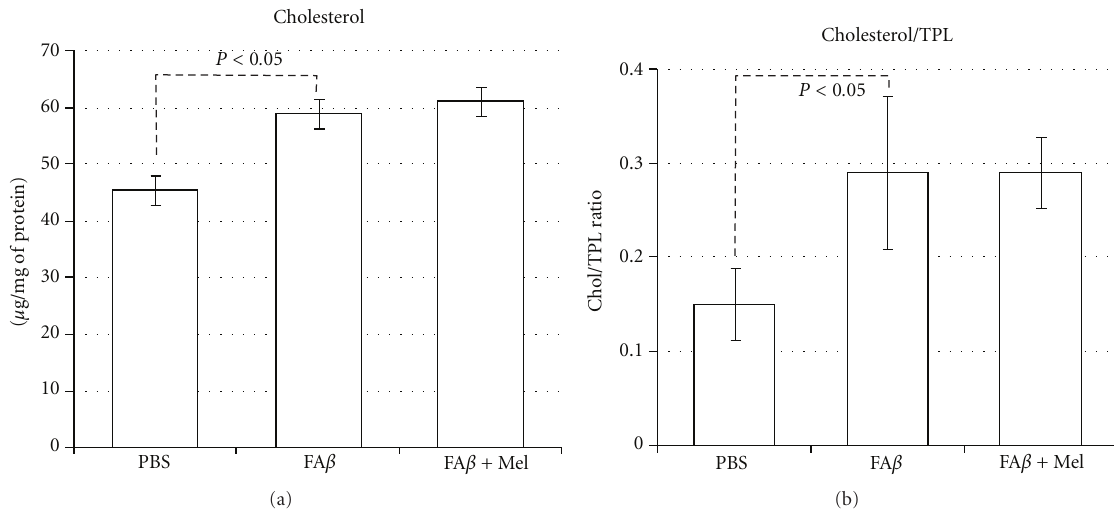
Figure 9: Cholesterol content in mitochondrial membranes is significantly increased in fA β injected brains. The H 2 O 2 control group (data not shown) and the fA β experimental group, which showed the more important overproduction of free radicals and the lowest membrane fluidity, coincide with the highest cholesterol content. However, in spite of its ability to scavenge free radicals and restore membrane fluidity, melatonin was unable to reduce cholesterol content in mitochondrial membrane. Compared according to their relative values, cholesterol and total phospholipids ratio was significantly altered.